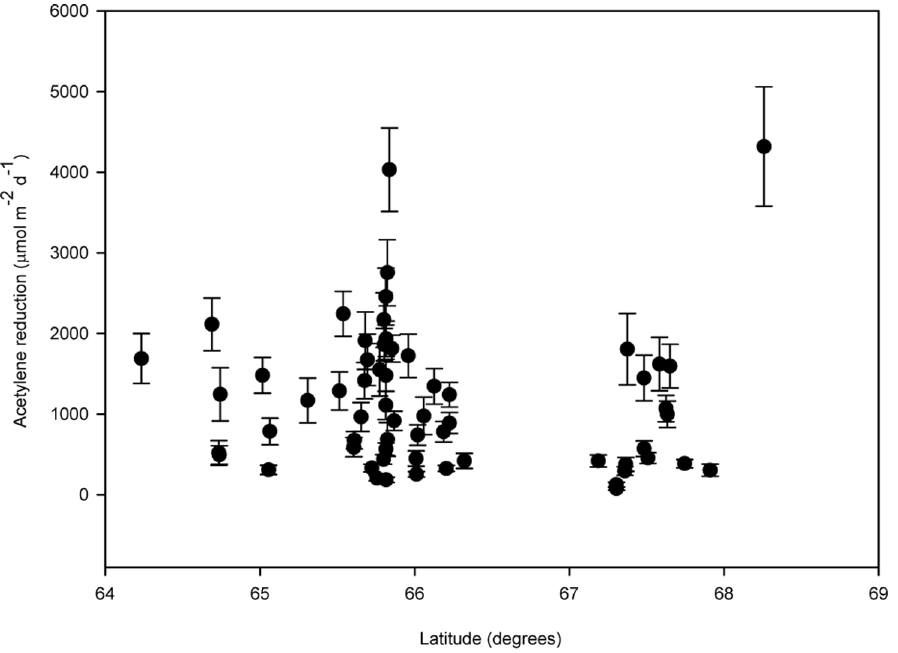
Figure 1. Survey of nitrogenase activity in subarctic alluvial meadows at 71 total wet meadow sites along 10 individual river systems in northern Sweden (see SI). The horizontal solid line at 1150 m mol m 2 2 d 2 1 represents the average for all 71 sites. Bars represent one standard error of the mean acetylene reduction value at each site (n=12).